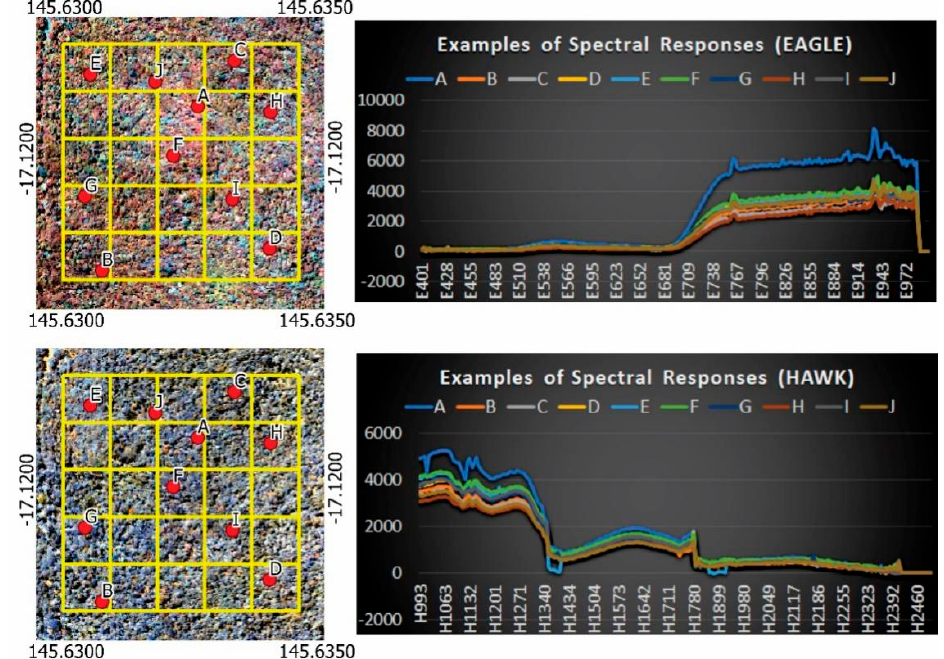
Figure 2. Examples of spectral responses from Eagle ( top figure ) and Hawk ( bottom figure ) sensors at 10 random points at the study